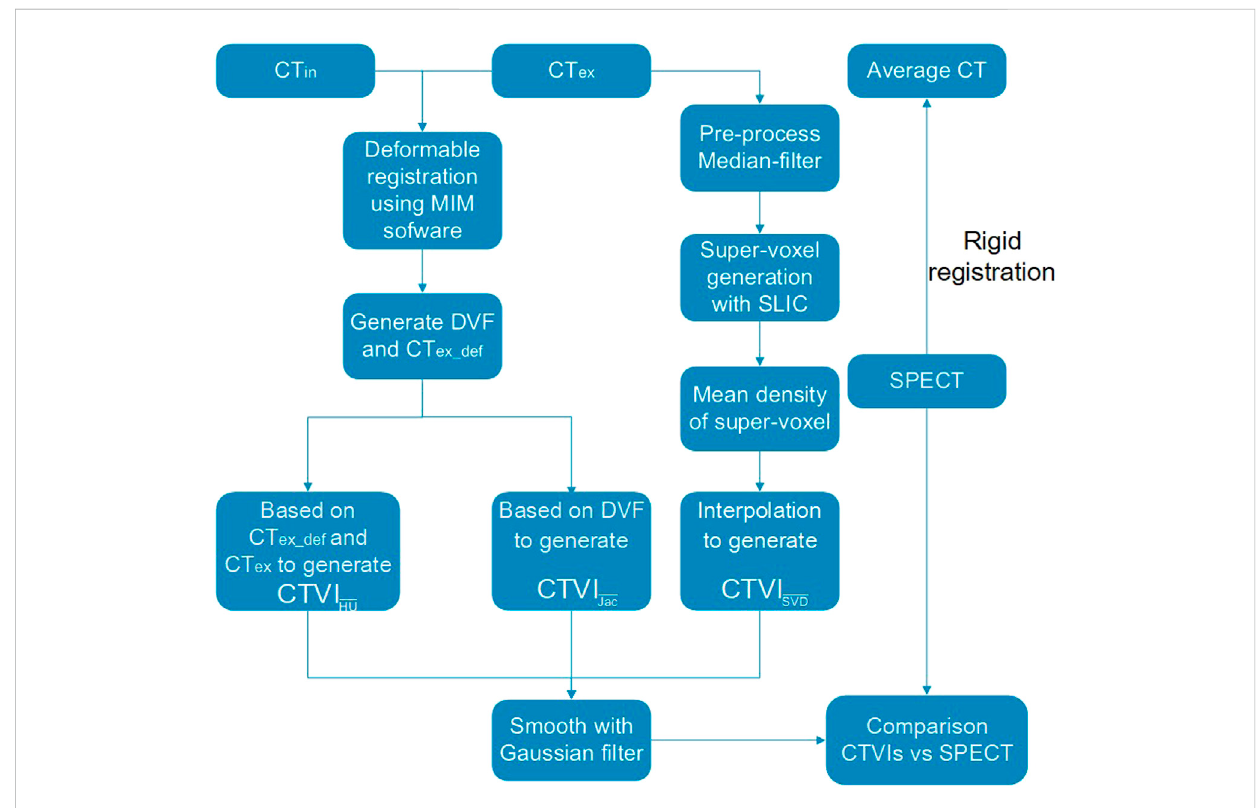
FIGURE 1 Flowchart of this study for comparing the CTVI SVD , CTVI HU , and CTVI Jac with SPECT.